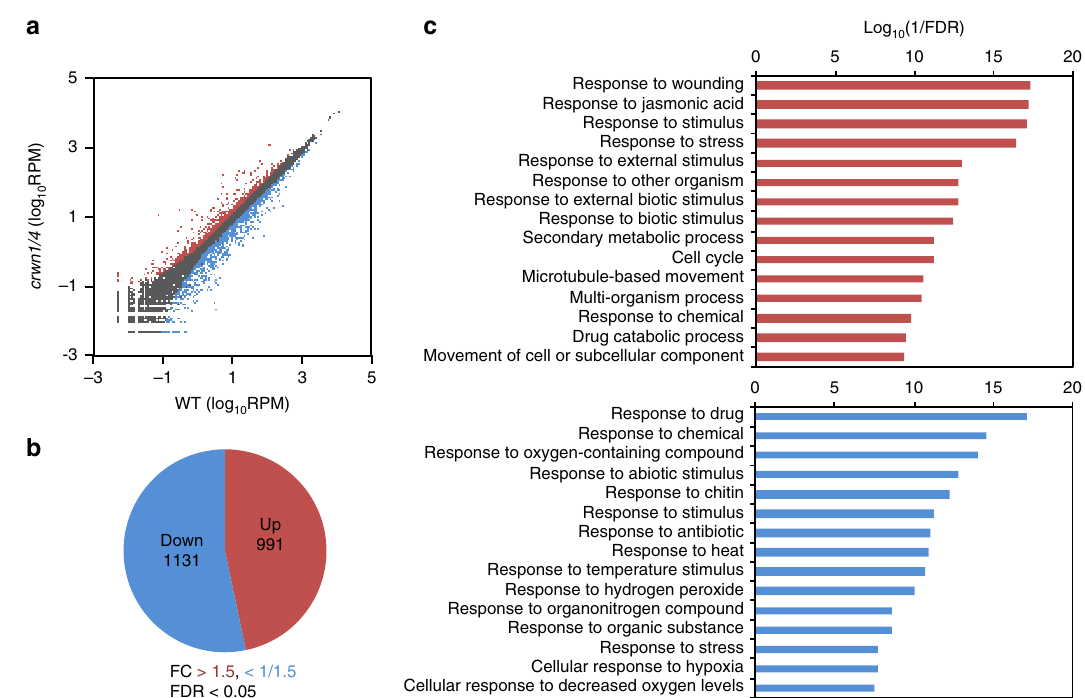
Fig. 3 CRWNs affect gene expression pattern. a Scatter plots of RNA-seq data comparing mRNA abundance between WT and crwn1crwn4 . Red marks denote mRNAs upregulated more than 1.5-fold (FDR < 0.05); blue marks denote those downregulated to <0.667-fold (FDR < 0.05); gray marks denote other mRNAs. b Pie chart of differentially expressed genes (DEGs). c Enrichment analysis of GO terms for upregulated genes (top) and downregulated genes (bottom). GO analysis according to biological